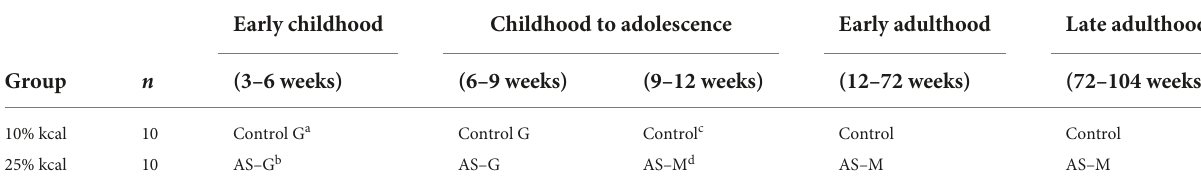
TABLE 1 Dietary intervention of groups at different life